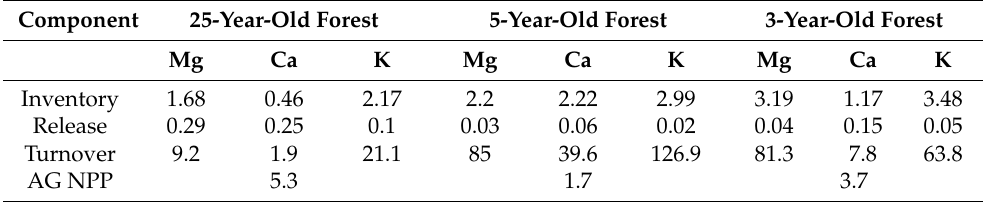
Table 4. Soil Mg, Ca, and K inventories (kg m − 2 ), release rates (kg m − 2 a − 1 ), and turnover times (a) in 25-, 5- and 3-year-old Rhizophora apiculata forests in southern Thailand. Soils were sampled to depth of maximum root penetration. AG NPP (kg C m − 2 a − 1 ) = aboveground net primary production. Source: